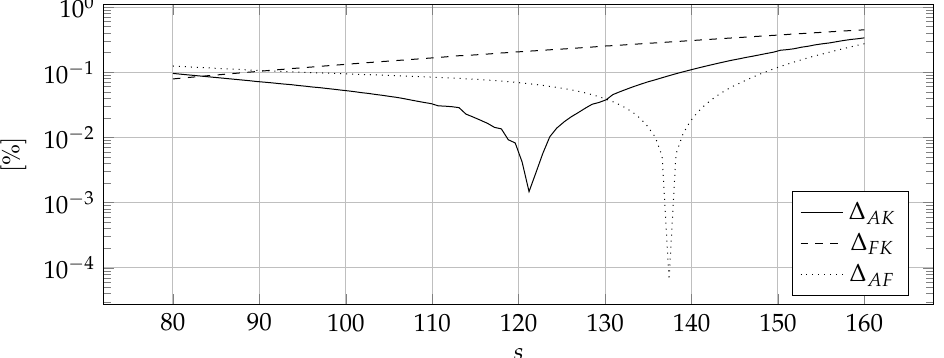
Figure 10. The influence of the sharpness parameter s on the ∆ AK , ∆ FK , and ∆ AF error measures for 120 collocation